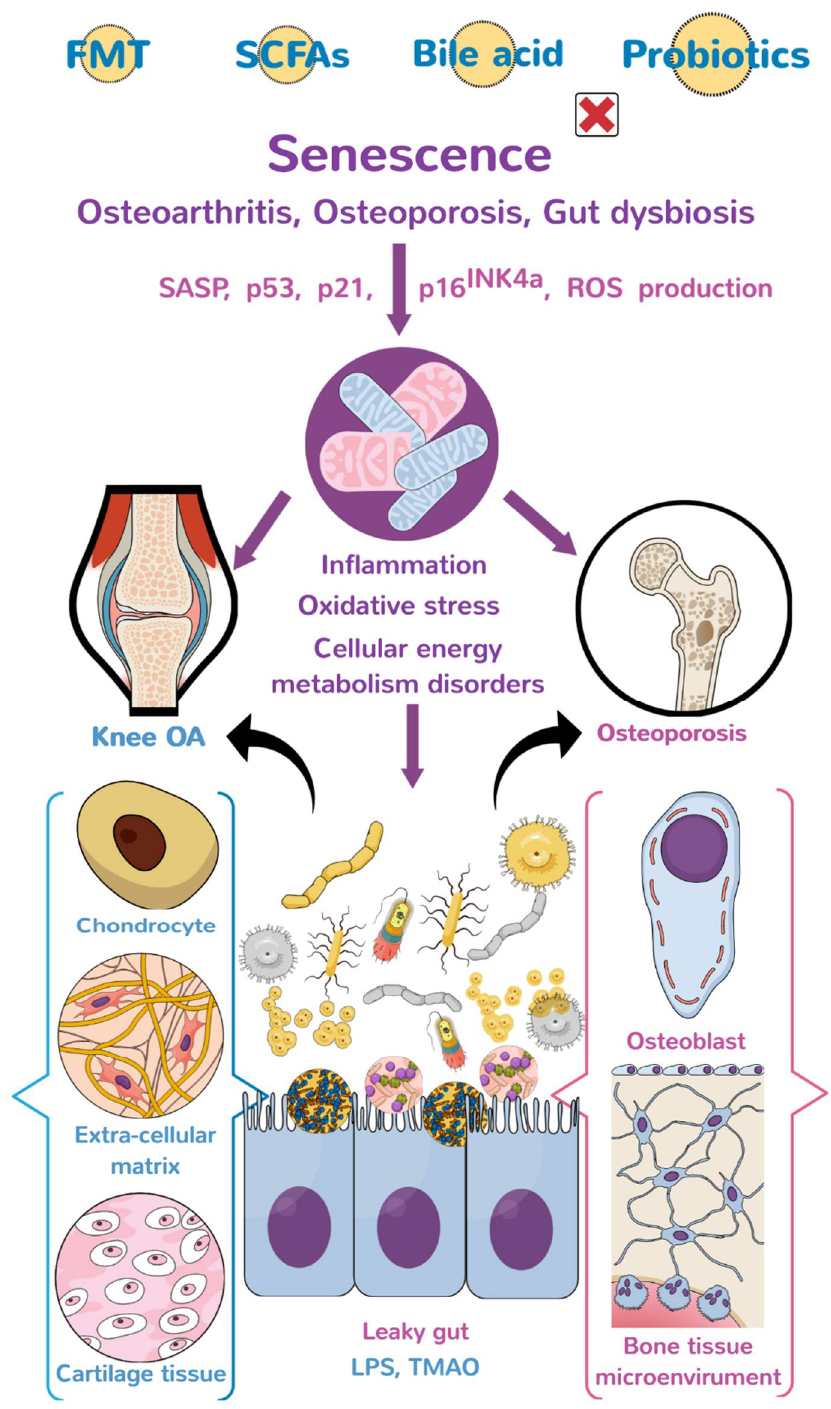
Figure 1. The diagram of the gut-joint axis and gut-bone axis. Gut dysbiosis aggravates inflammation, mitochondrial dysfunction, oxidative stress, and dysregulation of cellular energetics through liposac- charides and metabolites, induced extracellular matrix underproduction, and senescent bone cell (chondrocyte) overburden, which accelerate the development of osteoporosis (OP) and osteoarthritis (OA). The graphs of bone, knee, osteoblasts, chondrocytes, mitochondria, and gut microorganisms are subscribed from Mind the Graph (https://mindthegraph.com, accessed on 1 January 2020), which authorizes the author (W.-S.L.) all the rights to use. FMT: fecal microbiota transplantation; SCFAs: short-chain fatty acids; SASP: senescence-associated secretory phenotype; LPS: lipopolysaccharide; and TMAO: